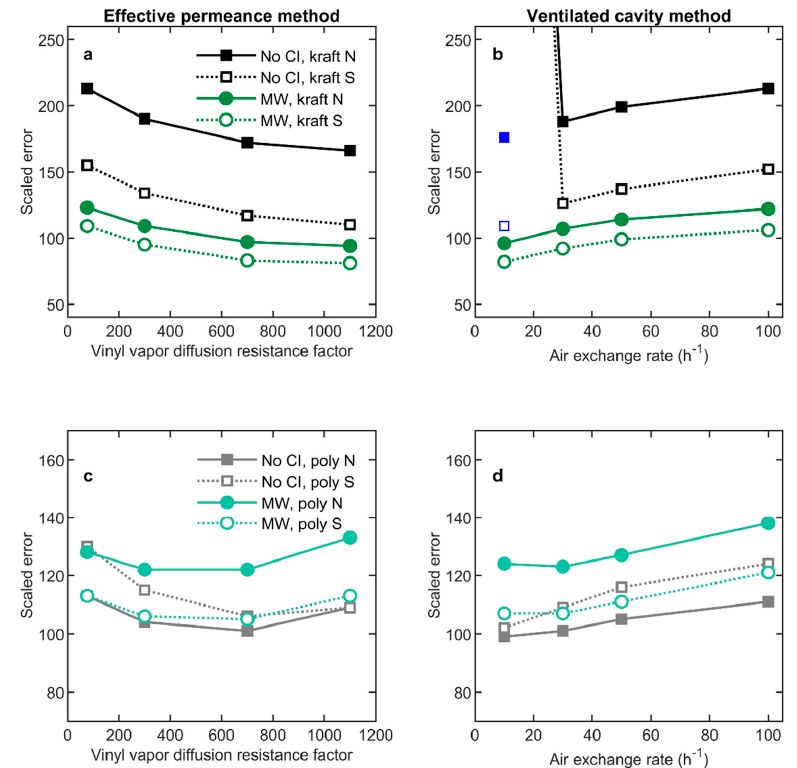
Figure 20. Scaled error for different methods of modeling vinyl siding: left ( a , c ) vapor diffusion resistance factor values; right ( b , d ) ventilated cavity having air exchange with exterior.